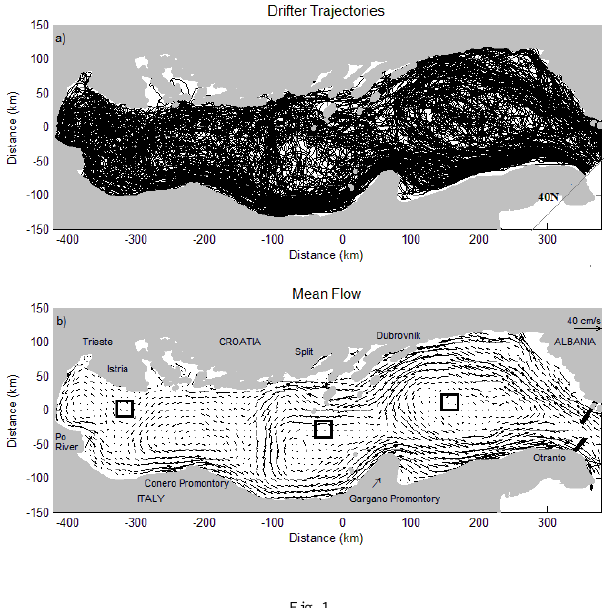
Fig. 1. (a) Drifter trajectories in the Adriatic Sea for the period Au- gust 1990–March 2007. (b) The mean flow obtained by averaging the drifter data in circular bins of 10km radius. Selected geograph- ical names and two sections in the vicinity of the Otranto Channel are shown, as well as the three squared areas considered for the transit time pdfs shown in Figs. 2 and